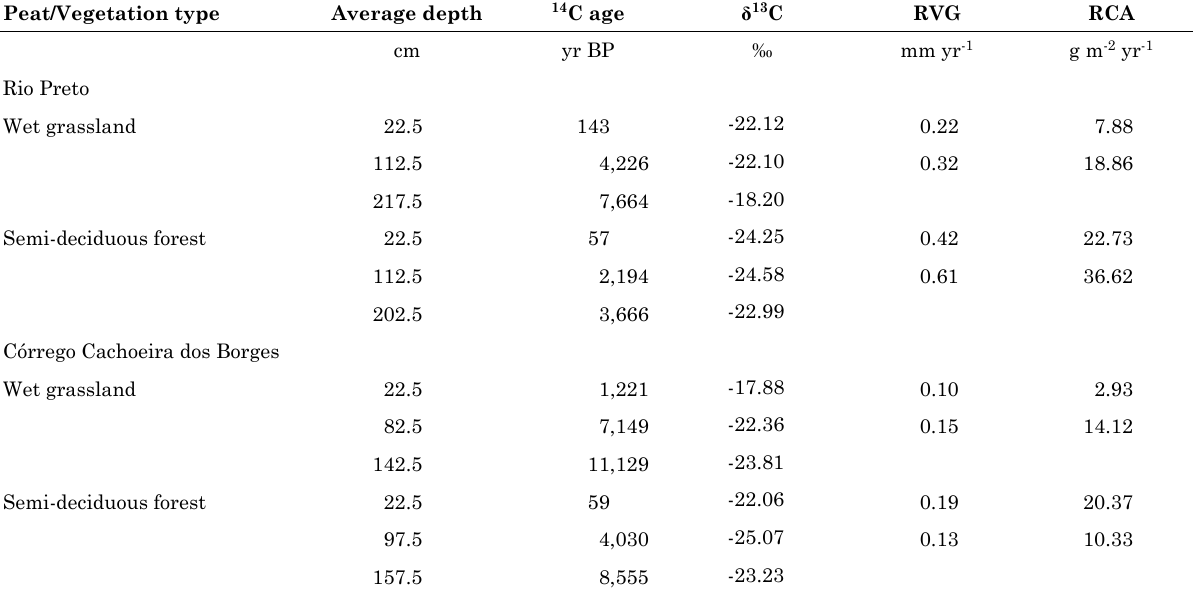
Table 3. Radiocarbon ages, δ 13 C content, vertical growth rate (RVG), and carbon accumulation rate (RCA) in peats from tributaries of the Rio Araçuaí Peat/Vegetation